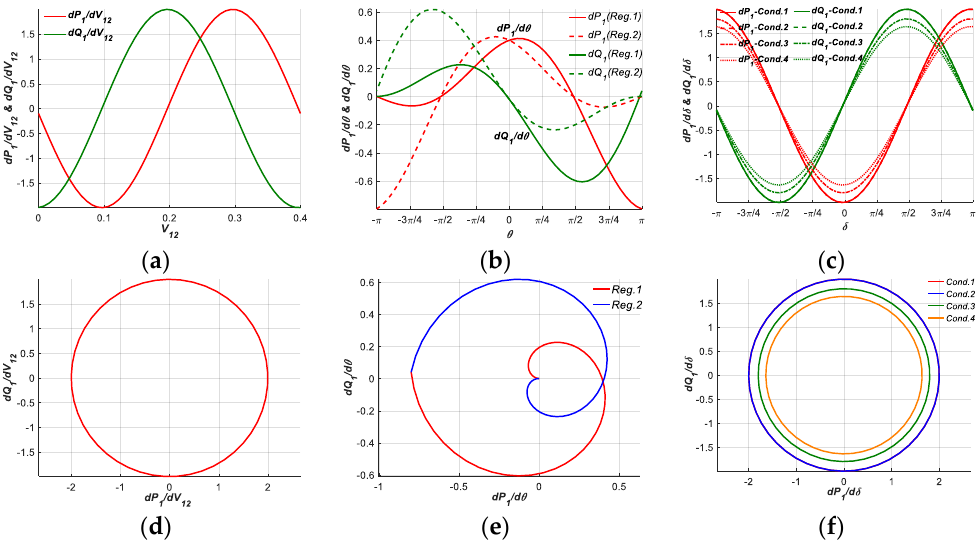
Figure 2. Curves of power flow gradients (PFG) to each characteristic independent variable (CIV) at SCP1 in planes: ( a ) Curves of the PFG to CIV1; ( b ) Curves of the PFG to CIV2. ( c ) Curves of the PFG to CIV3; ( d ) Curves of active power flow gradients (APFG) against reactive power flow gradients (RPFG) to CIV1; ( e ) Curves of APFG against RPFG to CIV2; ( f ) Curves of APFG against RPFG to CIV3.